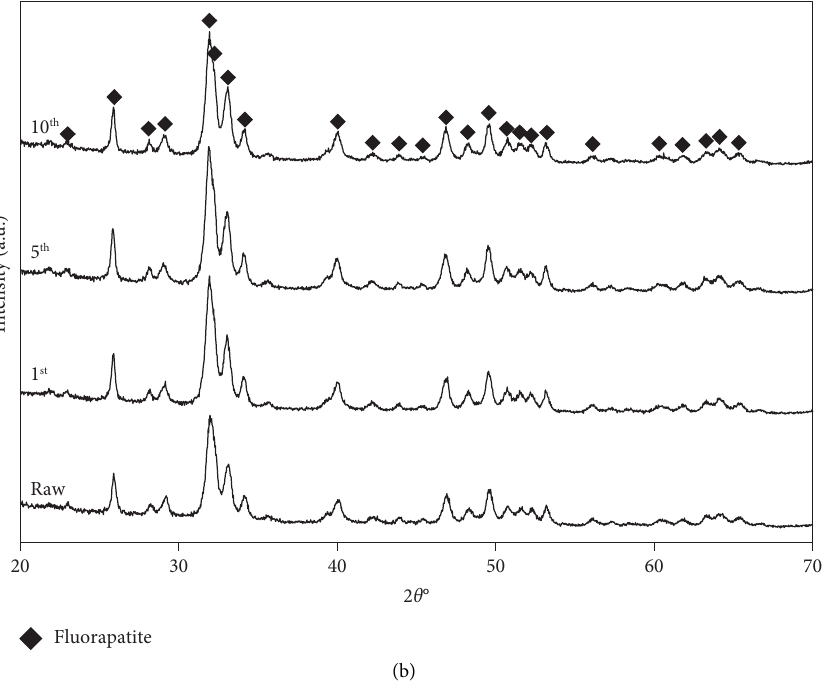
Figure 6: X-ray difractograms of raw and regenerated bone chars (a) before and (b) after fuoride adsorption. Samples were regenerated with 0.075mol/L NaOH.